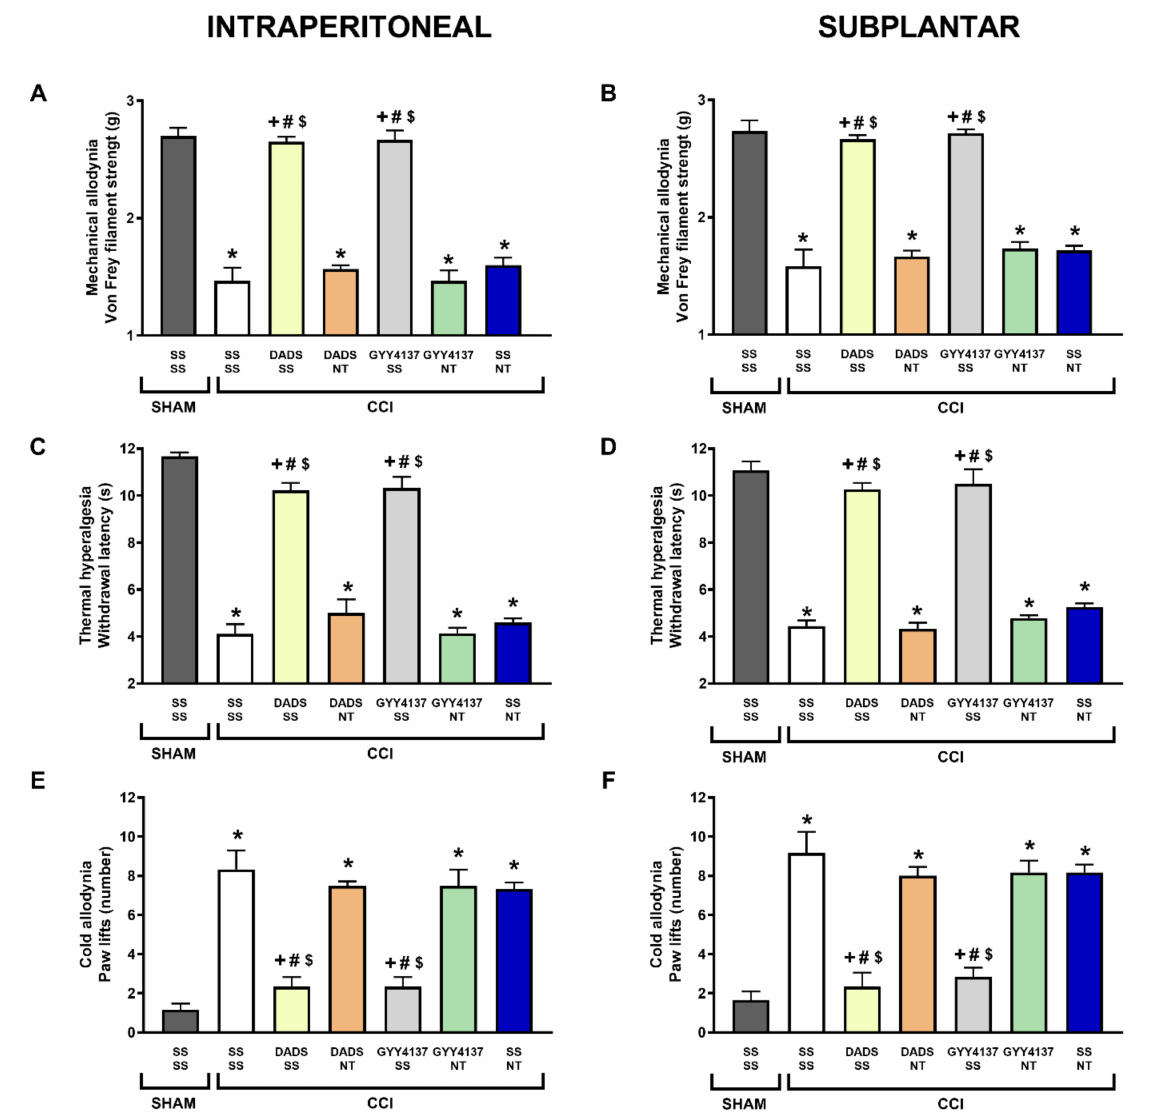
Figure 4. Reversal of the antiallodynic and antihyperalgesic effects of DADS and GYY4137 by naltrindole during neuropathic pain. The inhibitory actions induced by the i.p. injection of DADS (30 mg/kg) or GYY4137 (24 mg/kg) alone, and combined with naltrindole (NT) intraperitoneally (3 mg/kg) ( A , C , E ) or subplantarly injected (50 µ g) ( B , D , F ) in mice with CCI-provoked neuropathic pain, are represented. Sham-operated (SHAM) animals treated with SS plus SS are also represented. For each test, * represents significant differences vs. SHAM-animals treated with SS plus SS, + vs. CCI-mice treated with SS plus SS, # vs. CCI-mice treated with DADS or GYY4137 plus NT, and $ vs. CCI-mice treated with SS plus NT ( p < 0.05; one-way ANOVA, followed by Tukey test). Each column represents the mean, and vertical bars indicate SEM ( n = 6 animals for